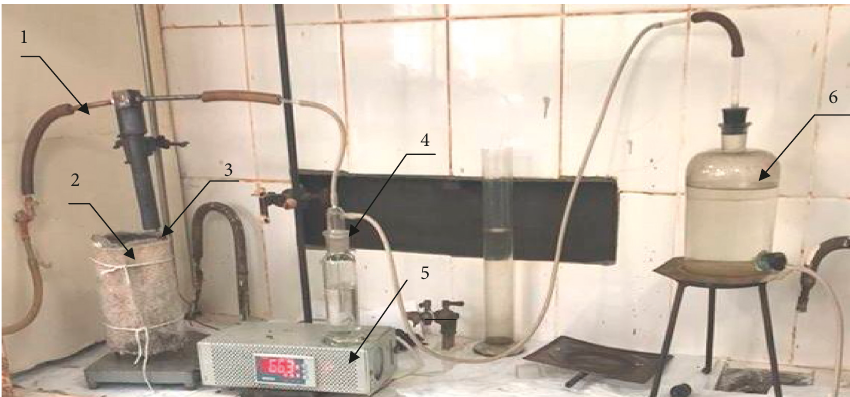
Figure 1: Laboratory equipment for the pyrolysis process: (1) nitrogen purging; (2) electric furnace; (3) reactor; (4) sealing trap; (5) temperature controller; and (6) eudiometer. Table 1: Wheat straw composition according to the literature and experimental data. Parameter Experimental